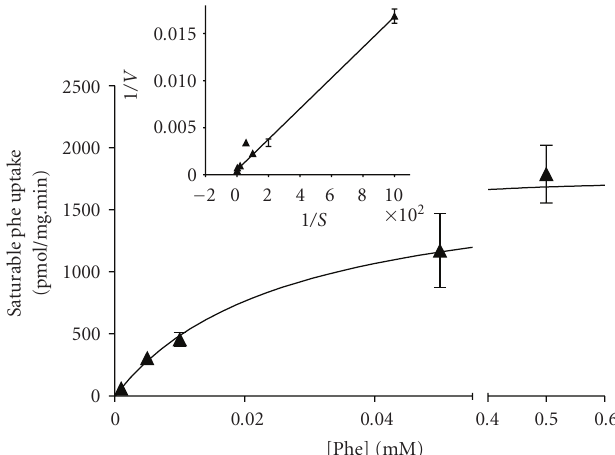
Figure 3: Saturable phenylalanine uptake into 3T3-L1 adipocytes. Uptake of [ 3 H]phenylalanine over 3 minutes at 5 di ff erent phenylalanine concentrations as indicated (between 1 μ M and 500 μ M) was measured. Values are shown ± SEM for 3 measurements in a representative experiment and are expressed with the nonsaturable component of uptake removed. Figure inset shows a Lineweaver-Burk plot relating [ 3 H]-phenylalanine uptake (corrected for nonsaturable component) against external phenylalanine concentration. The overall data provide estimated K m of 31 μ M and V max of 2.6 ± 0.5nmol · mg protein − 1 · min − 1 (mean ± sem, n = 6).